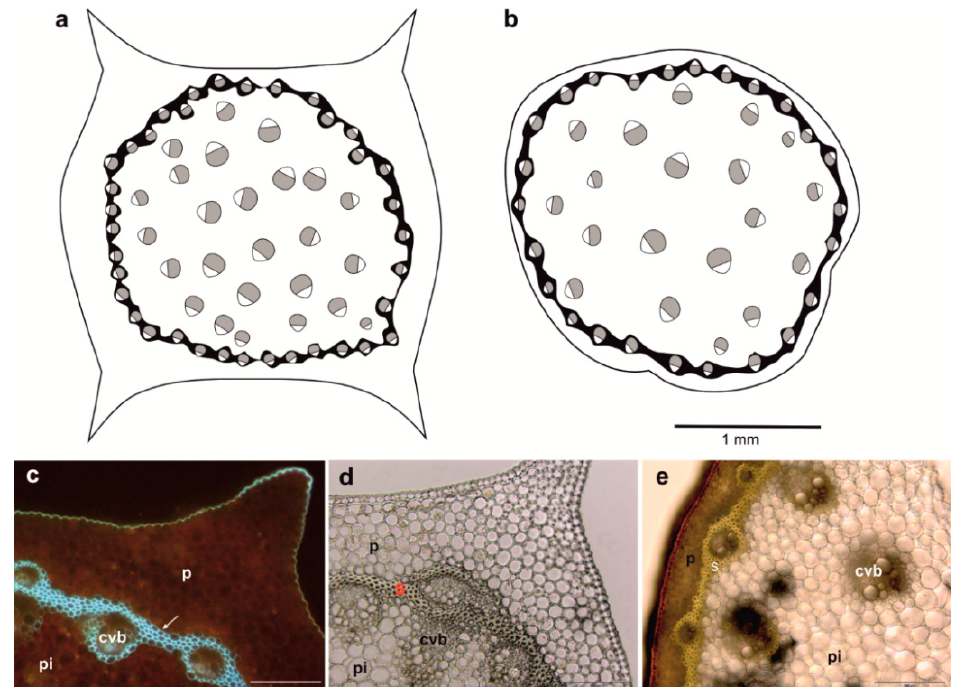
Figure 2. ( a , b ) Diagram showing shape of Polygonatum shoots as seen in transverse section; rectangular in P. odoratum ( a ) and circular in P. multiflorum ( b ). The sclerenchyma zone is marked black; the outer/inner parenchyma zone white. Vascular tissue is represented by scattered collateral bundles. ( c–e ) Photomicrographs of transverse sections of P. odoratum ( c , d ) and P. multiflorum ( e ) shoots. Scale bar = 200 μ m. (c)— section viewed under UV light. Fluorescence of lignified cell walls of sclerenchyma cells is marked with arrow. p — outer parenchyma zone; s — sclerenchyma zone; pi — inner parenchyma zone; cvb — collateral vascular bundle.